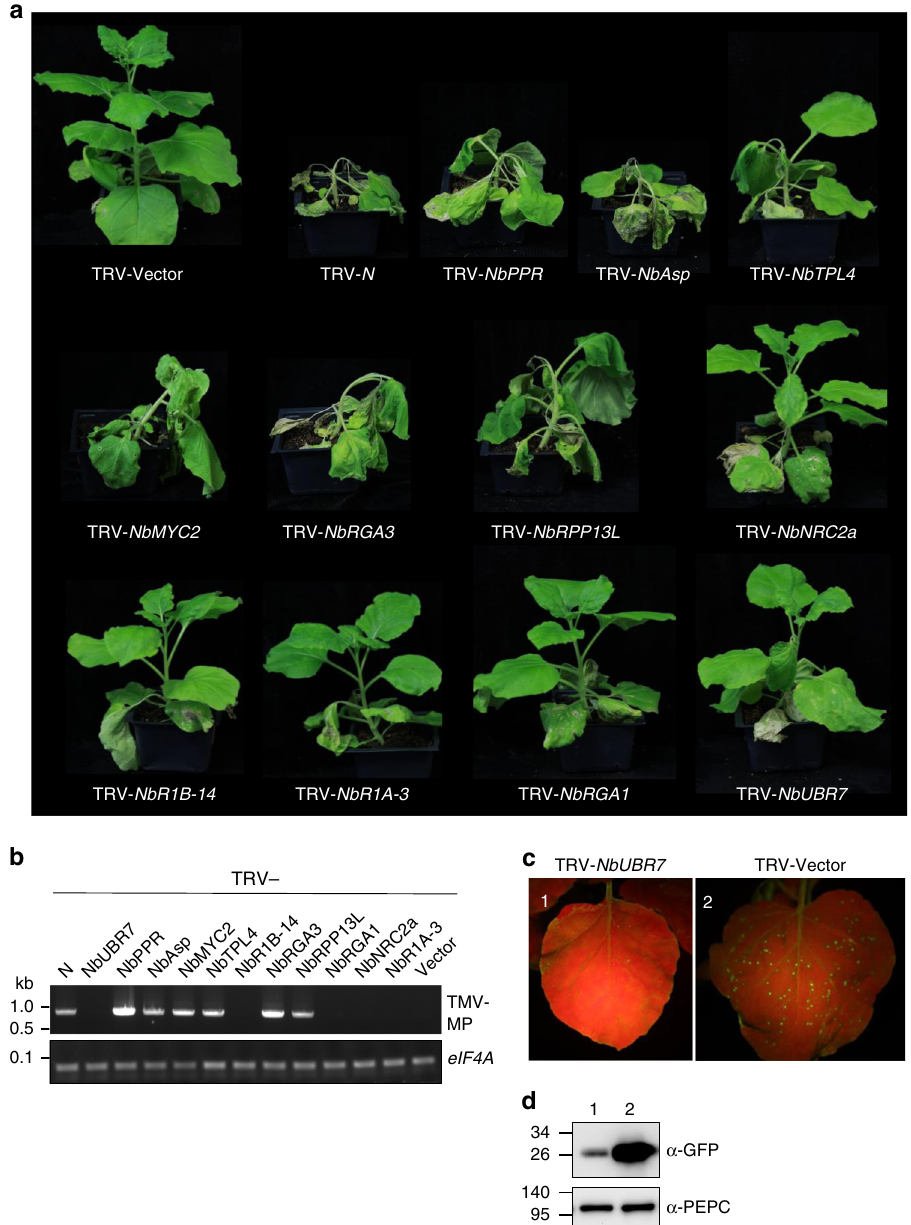
Fig. 3 Genetic screening of the function of candidate N NLR immune receptor interacting proteins in N -mediated resistance to TMV. a Phenotypic observation of the TMV-U1-incoluted N -containing transgenic N. benthamiana plants after being silenced with various target genes as indicted. Various recombinant TRV vectors containing different gene fragments were inoculated onto the N -containing transgenic N. benthamiana plants. 10 days later, TMV- U1 was rub-inoculated onto the upper leaves. Photographs were taken at 7 days after TMV inoculation and representative results are shown. These silencing experiments were repeated 2 – 3 times. b Analysis of the TMV RNA corresponding to the movement protein coding region in the upper uninoculated leaves by RT-PCR (TMV-MP, top panel). eIF4A was used as an internal control to validate the equal amount of total RNA used for RT-PCR (bottom panel). c Silencing of Nb UBR7 enhances N -mediated resistance to TMV. TMV-U1-GFP was rub-inoculated onto vector control or the Nb UBR7- silenced N -containing transgenic N. benthamiana leaves. Photographs were taken under UV light at 5 days post inoculation and representative results are shown (upper panels). d The expression level of GFP in the inoculated leaves was examined by western blot analysis using antibodies against GFP (top panel). PEPC served as loading control for equal protein loading (bottom panel). The molecular weight size markers in kDa are indicated at the left of each panel. Source data are provided as a Source Data fi control plants or other genes silenced plants (Fig. 3b). The NbRGA1 , and NbUBR7 showed similar phenotype to that of the downregulation of target genes expression in the various VIGS-vector control (Fig. 3a). We monitored the presence of recombinant TRV vector-inoculated plants was also con fi rmed TMV in the upper uninoculated leaves by RT-PCR. Our results by reverse transcription quantitative real-time PCR (RT-qPCR) showed accumulation of TMV in the upper uninoculated leaves (Supplementary Fig. 11). These results indicate that NbPPR , in N -, NbPPR -, NbAsp -, NbMYC2 -, NbTPL4 -, NbRGA3 -, and NbAsp , NbMYC2 , NbTPL4 , NbRGA3 and NbRPP13L are NbRPP13L -slienced plants, but not in the VIGS-vector